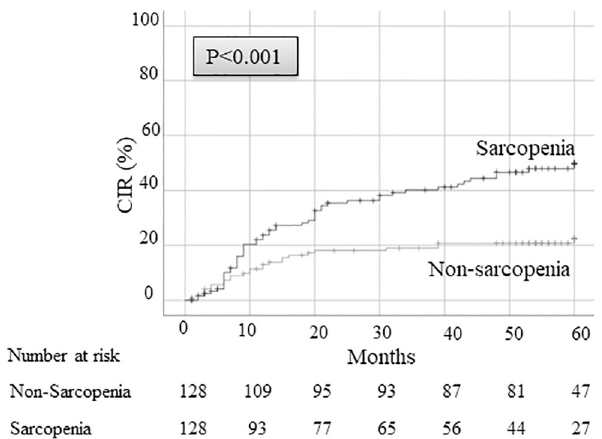
Fig 2. CIR rate after surgery between sarcopenia patients and non-sarcopenia patients. CIR, cumulative incidence of recurrence.